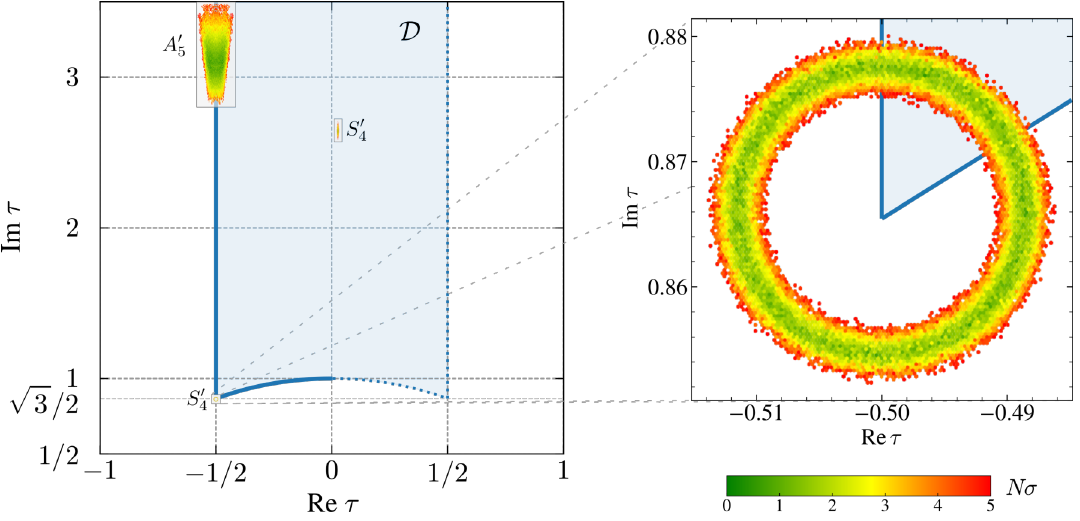
Figure 5. Allowed regions in the τ plane for the models discussed in sections 3.4 and 4.2 (left). The region corresponding to the model of section 4.2 is magnified (right). The green, yellow and red colours correspond to different confidence levels (see legend). Points outside the fundamental domain, while redundant, are kept for illustrative